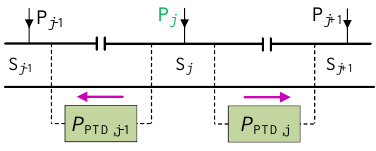
Figure 13. Adjacent transmission. Figure 13. Adjacent